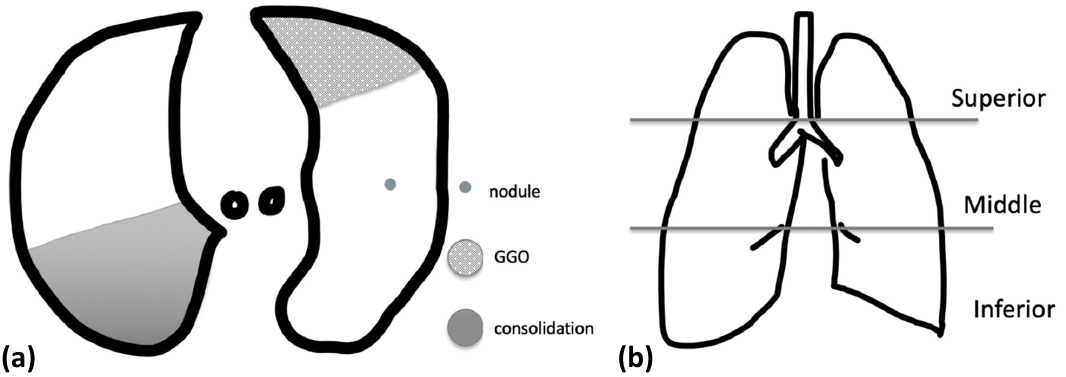
Figure 1. ( a ) Schematic representation of nodule, ground-glass opacity (GGO) and consolidation on an axial image; ( b ) schematic coronal representations of zones: superior ones above the carina, middle zones between the carina and the inferior pulmonary vein, and lower zones which are below the inferior pulmonary vein.